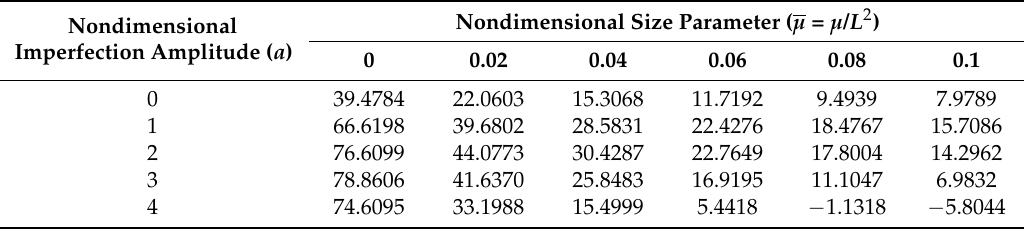
Table 1. Nondimensional buckling load for a variety of initial curvatures and size parameter for a =